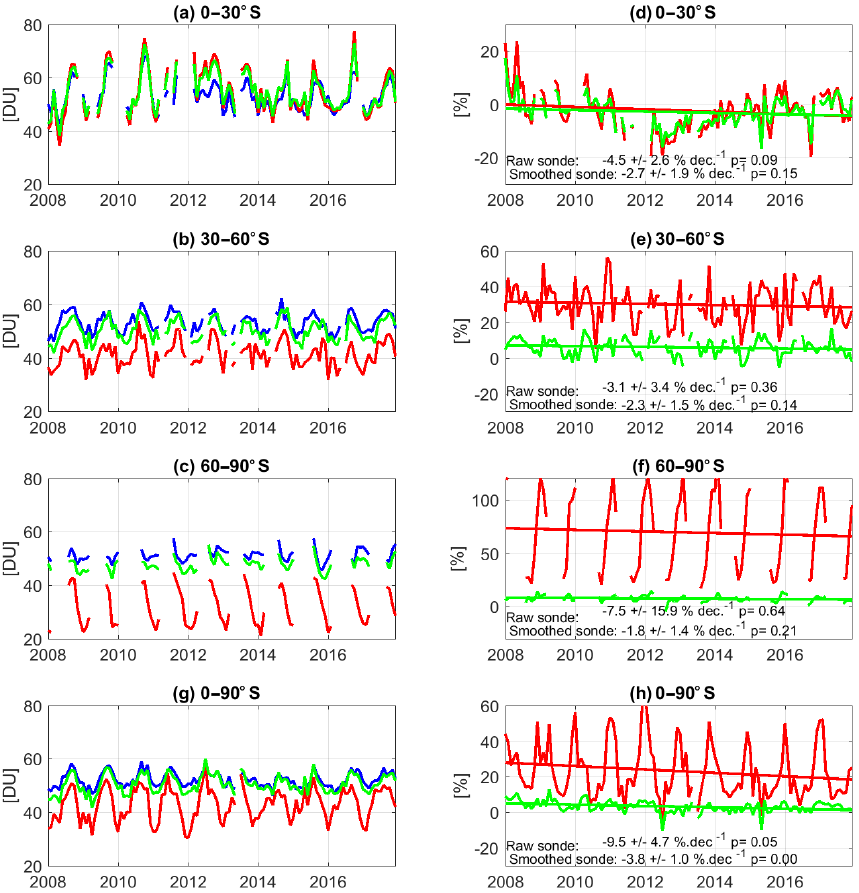
Figure 10. Same as Fig. 9 for SOFRID-O3 v1.6 in the Southern